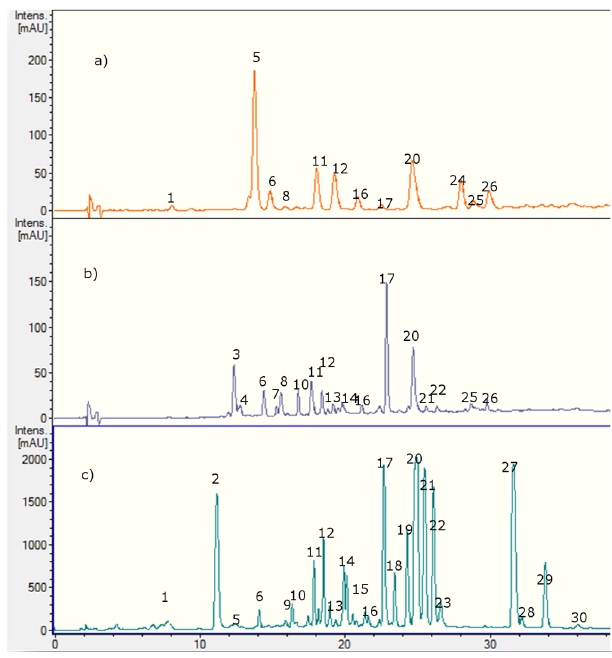
Figure 2. HPLC-UV chromatograms at 280 nm of ( a ) Nolana leptophylla , ( b ) N. aplocaryoides and ( c ) N. ramosissima collected in Paposo Valley, II region of Chile.